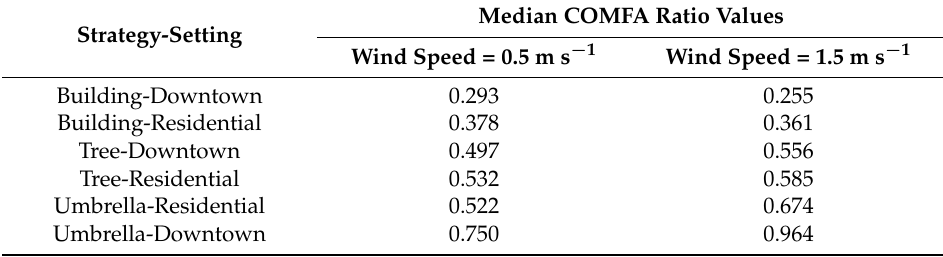
Table 4. Median of the COMFA ratios caused by each of the strategy-settings when the wind speed was set at 1 m s − 1 at the reference site and either 0.5 m s − 1 or 1.5 m s − 1 at the strategy site.